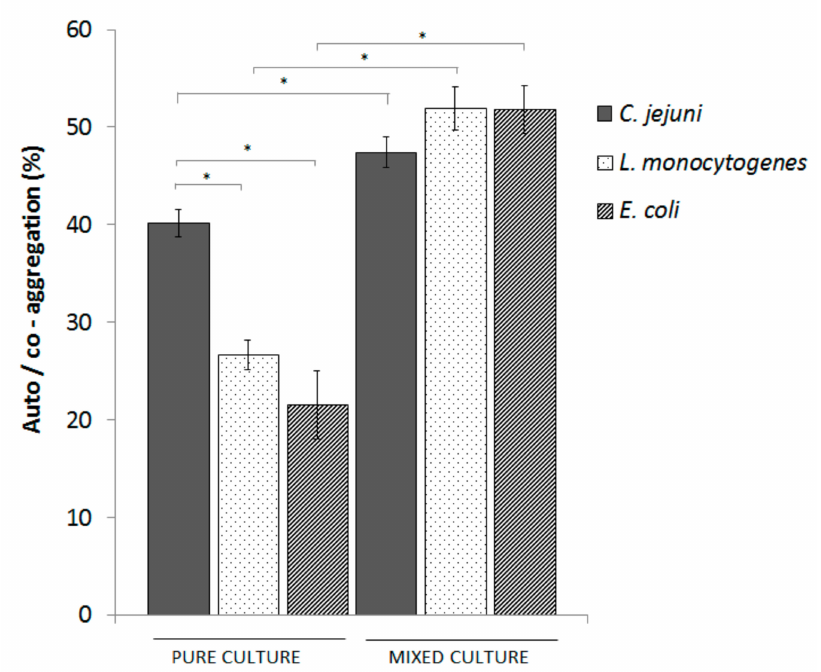
Figure 3. Aggregation and co-aggregation of C. jejuni , E. coli, and L. monocytogenes as mono-cultures and mixed co-culture of the three bacteria after 24 h. Data are means ± standard deviations. *, p < 0.001; as indicated.